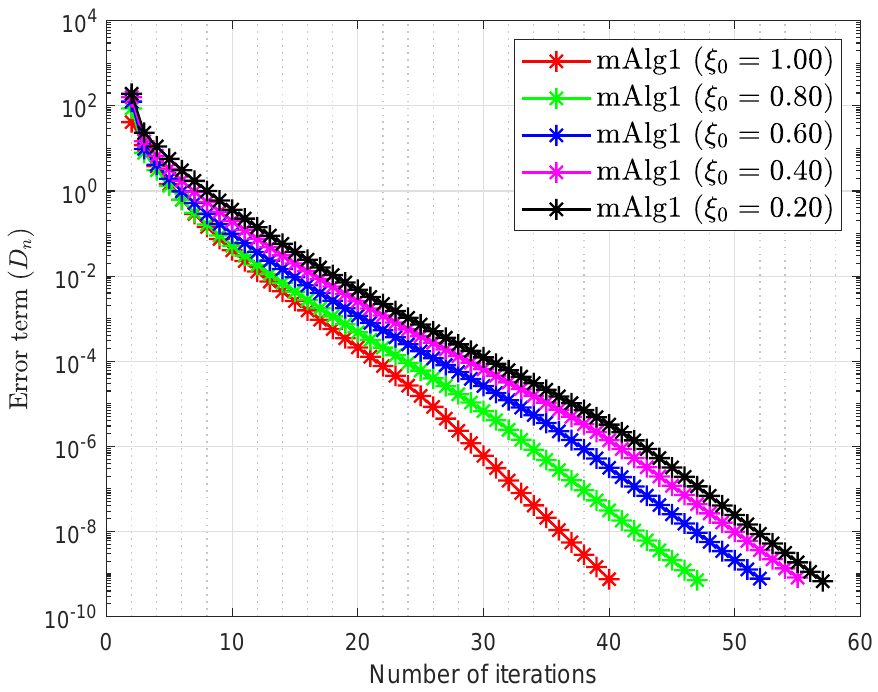
Figure 4. Example 1: numerical behaviour of Algorithm 1 by letting different options for ξ 0 while m =